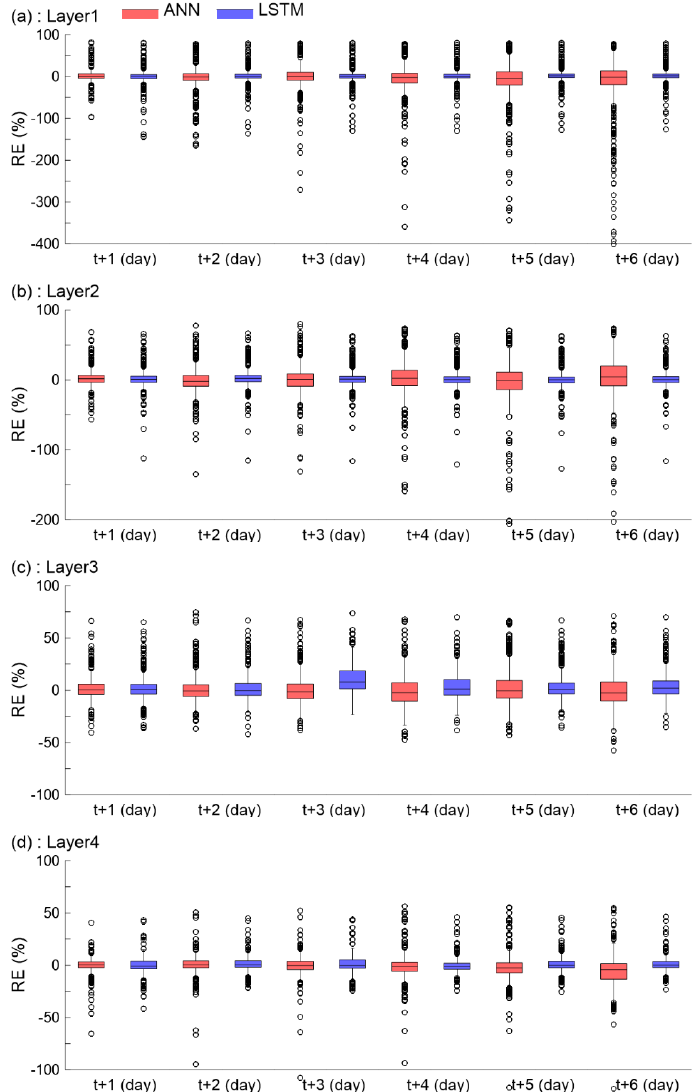
Figure 7. Box plots representing relative error (RE, %) of predicted soil moisture from both models for four layers (( a ): Layer 1, ( b ): Layer 2, ( c ): Layer 3, ( d ): Layer 4). The red box represents ANN, and the blue is LSTM results.